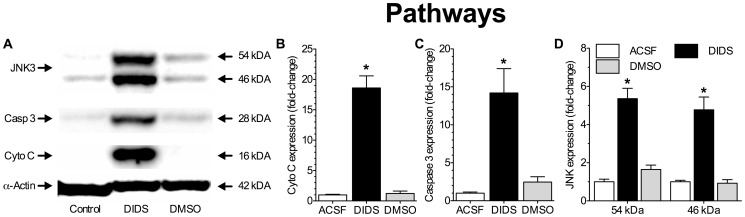
DIDS upregulates apoptotic pathways in neurons.(A) Sample Western blots of apoptosis-related protein expression from neurons treated as indicated for 6 hrs. (B–D) Summaries of fold-change in cytochrome C (B), caspase 3 (C), and JNK3 (D) protein expressions from (A) normalized to α–actin expression in the same sample. Data are mean ± SEM from 3 separate experiments for each protein and treatment. Asterisks (*) indicate significant difference from untreated controls (p<0.05).